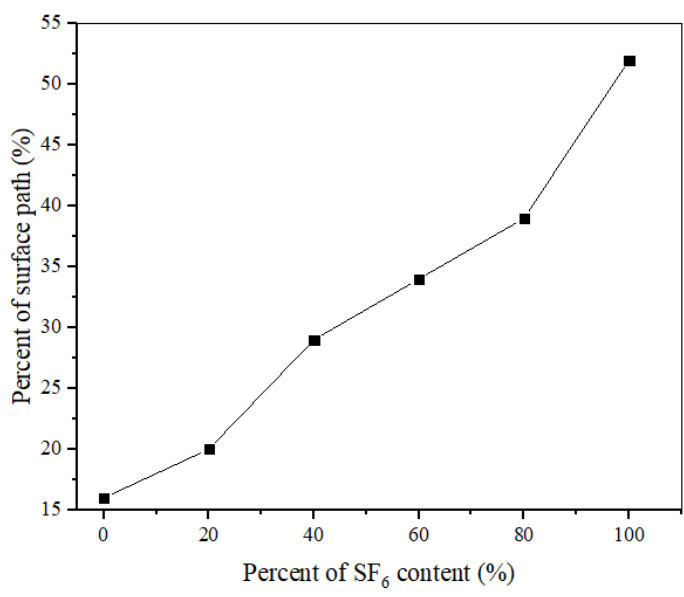
Figure 17. The percent of surface path at the various SF 6 contents.